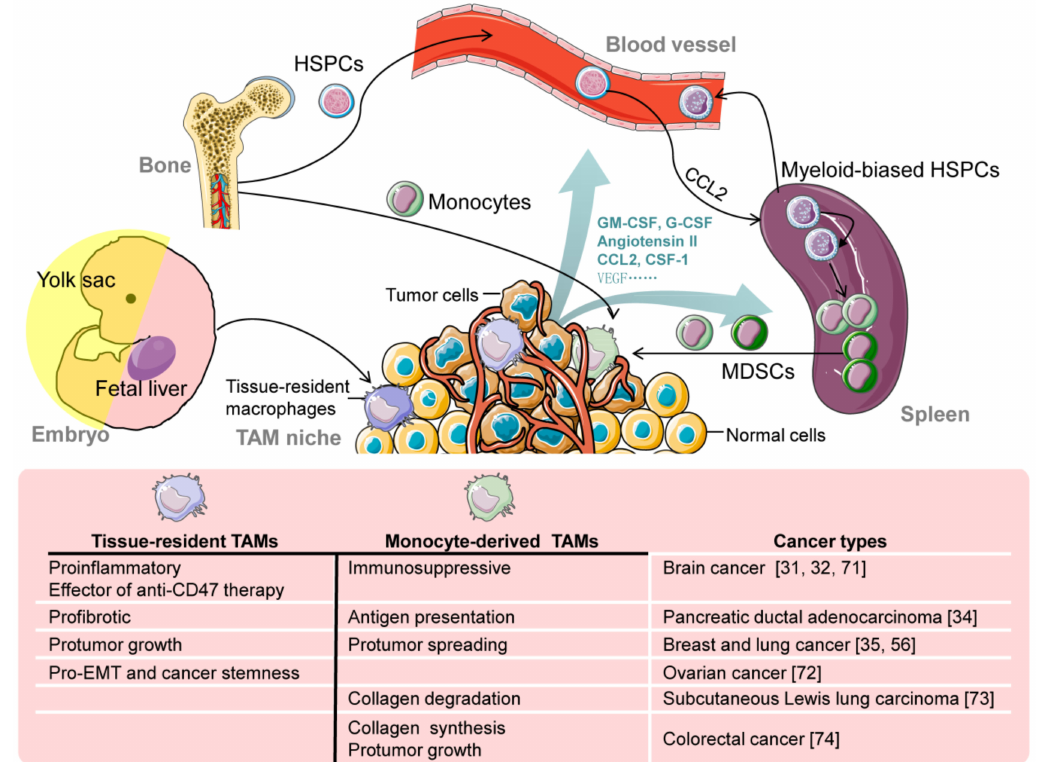
Figure 1. The origin and functional heterogeneity of tumor-associated macrophages (TAMs). There are two main origins of TAMs: tissue-resident macrophages (TRMs) and hematopoietic stem and progenitor cell (HSPC)-dependent monocytes. Most TRMs originate from the yolk sac and fetal liver. Under steady-state conditions, TRMs self-maintain in situ throughout adult life and are restrictedly contributed by circulating monocytes from HSPCs, depending on organs and increases in age. Monocyte-derived TAMs originate from not only bone marrow HSPCs but also splenic myeloid-biased HSPCs induced by cancer. Tumor-derived factors mediate the expansion and differentiation of myeloid-biased HSPCs and the recruitment and differentiation of monocytes and myeloid-derived suppressor cells (MDSCs). Tissue-resident TAMs and monocyte-derived TAMs (moTAMs) have different functions in tumor progression. EMT: epithelial-mesenchymal transition; HSPCs: hematopoietic stem and progenitor cells; MDSCs: myeloid-derived suppressor cells; TAMs: tumor-associated macrophages; TRMs: tissue-resident